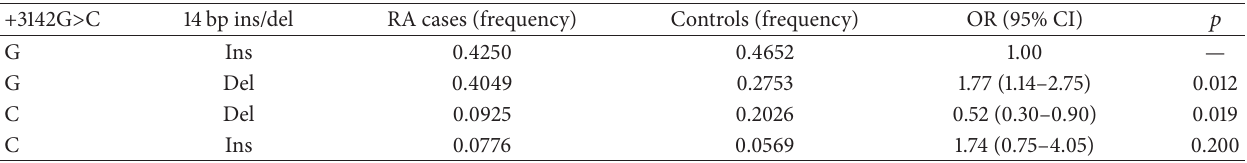
Table 3: Haplotype association of HLA-G +3142G > C and 14bp ins/del variants with rheumatoid arthritis (RA) risk. +3142G >